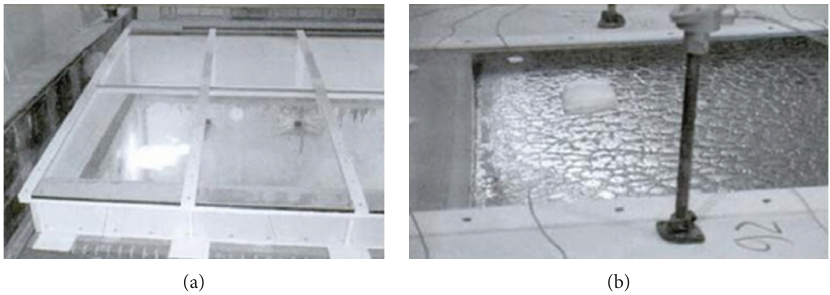
Figure 12: Fire tests on glazing floor, as reported in [74]. (a) Initial state and (b) failure pattern (detail).